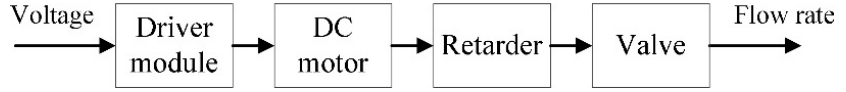
Figure 3. Block diagram of 463020 electric proportional valve control system.